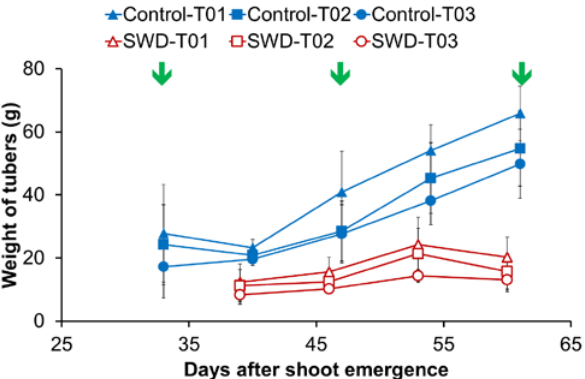
Figure 1. Evolution of tuber weight during the growth period expressed in days after shoot emergence (DASE). For each of the eight plants (4 Control & 4 subjected to severe water deficit SWD), the three heaviest tubers were labeled T01 to T03 in decreasing order of mass at harvest. Weight values correspond to the average of four observations ( n = 4) and standard deviation are indicated by the segment bars. Arrows indicate the measurement dates for physiological parameters. In the case of SWD plants, dates correspond, respectively, to 1 to 5 weeks after irrigation was withheld.